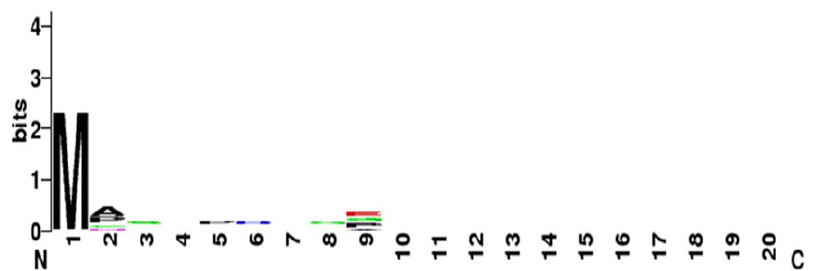
Figure 6. Main proteins associated with insulin signaling pathway. Using WebLogo.